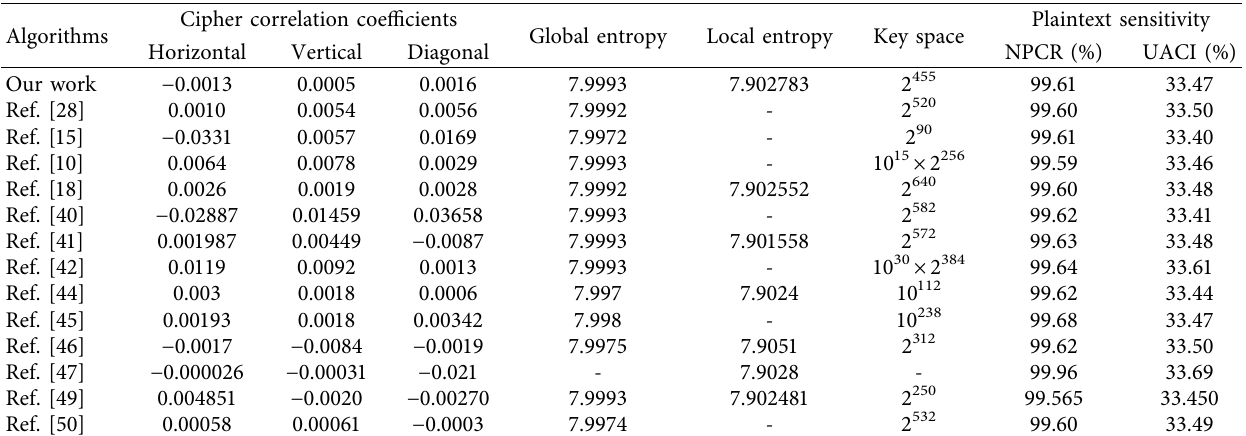
Table 9: Security